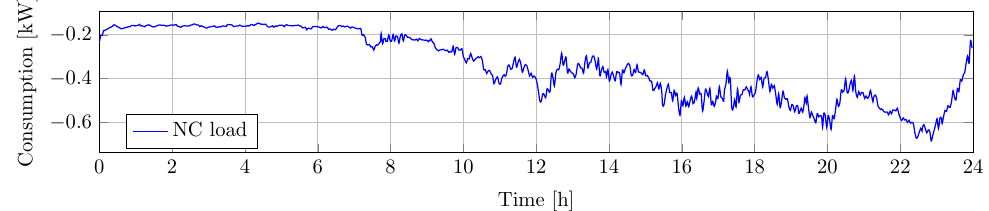
Figure 5. Noncontrollable electrical load for the four different